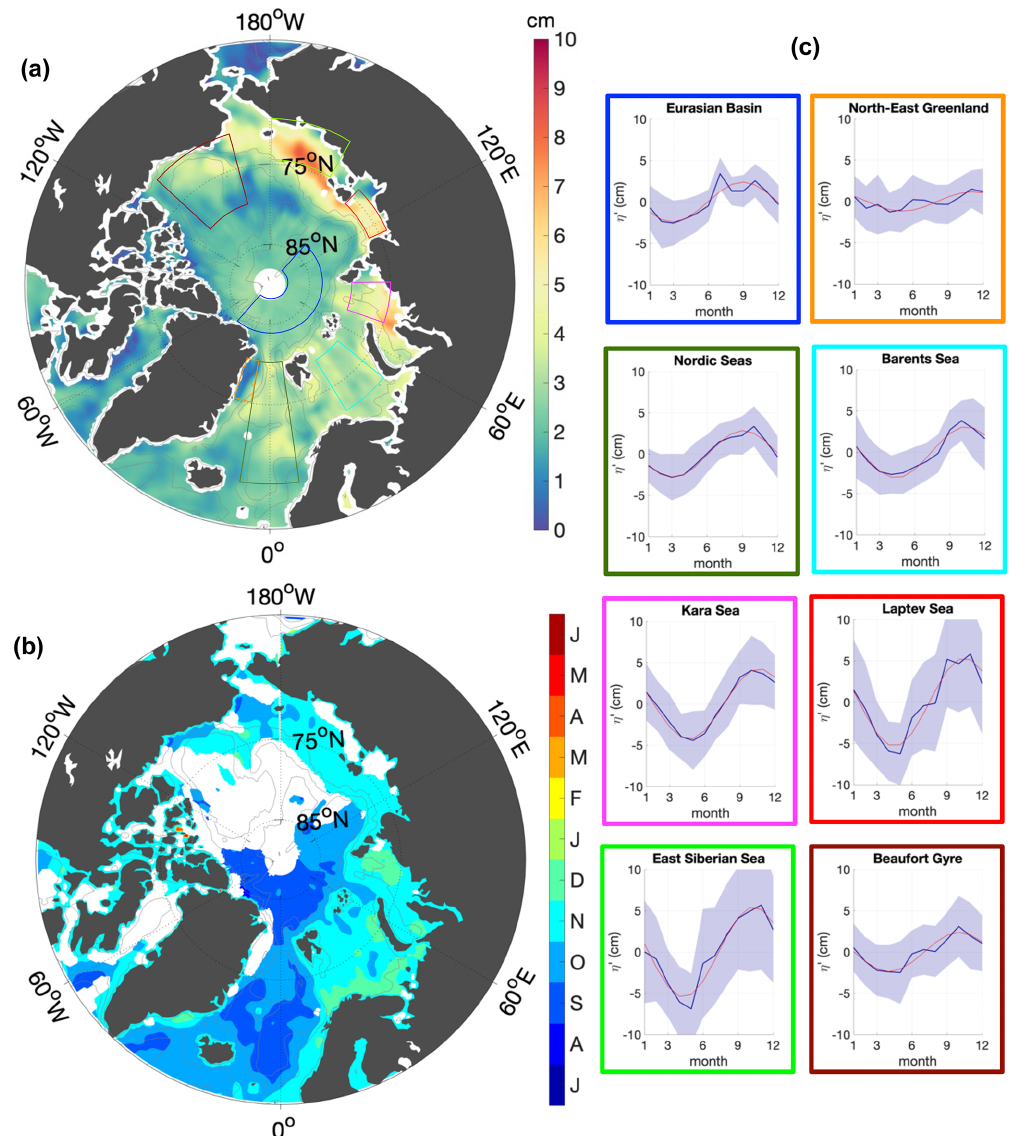
Figure 14. (a) Amplitude and (b) phase of the η (cid:48) annual harmonic oscillation between 2011 and 2018. Blanked areas in panel (b) are those areas where the seasonal cycle explains less than 20% of the total variance. (c) Panels representing the η (cid:48) monthly climatology (blue line, with standard deviation as shading) and the η (cid:48) seas (red line) averaged over the areas marked in the map with the corresponding color. Bathymetry contours are drawn at 100, 1000 and 2500m